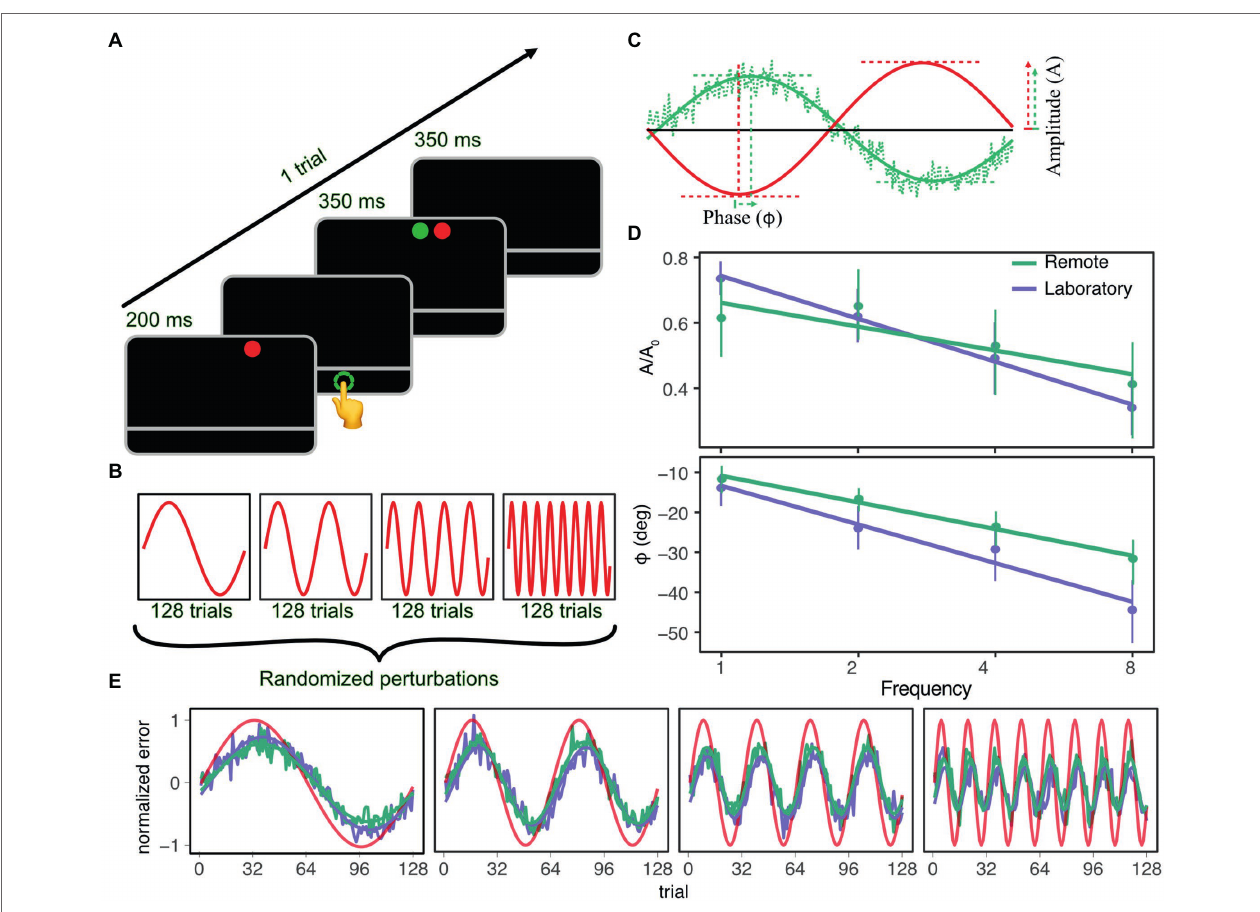
FIGURE 2 | (A) Experimental procedure for each trial. (B) Perturbation in the four sequences of trials, each one characterized by a different frequency of the sinusoidal offset. (C) Definition of amplitude (A) and phase ( φ ) of the adaptation response (green line) with respect to the sinusoidal offset (red line). (D) Normalized amplitude (top panel) and phase (bottom panel) of the adaptation response as a function of frequency of perturbation for participants in the remote and laboratory setting (blue and purple symbols, respectively). Points represent estimates of the parameters as they are extracted from the model in Eq. 3.4, lines are bootstrap- based confidence intervals. (E) Average response of the two groups over trials in the four sequences. Perturbations are shown in red, and inverted for an easier reading of the